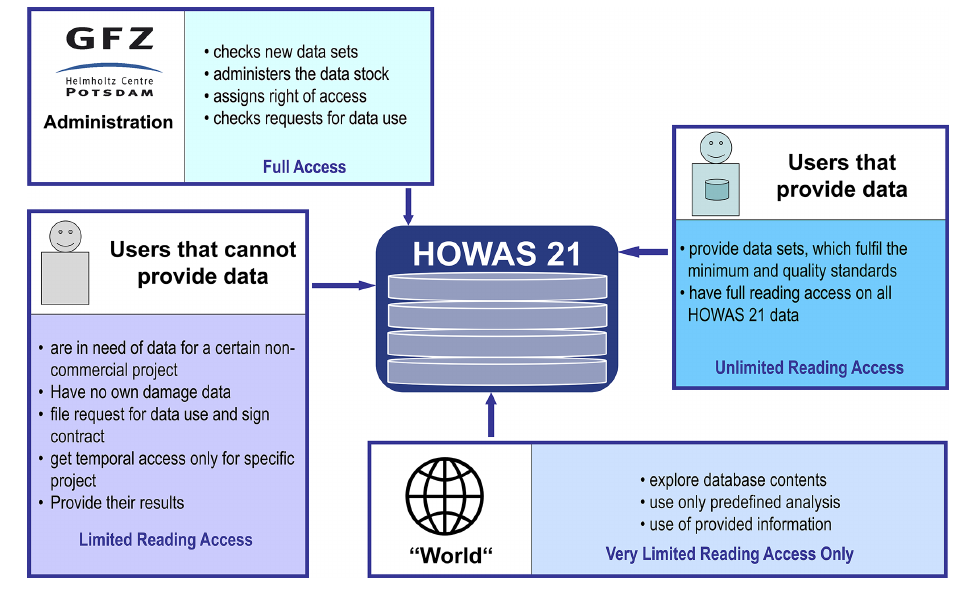
Figure 1. HOWAS 21 utilisation concept. Table 1. Exemplary overview of the main damage information tables for private households (adapted from Thieken et al., 2009, and Kreibich et al.,